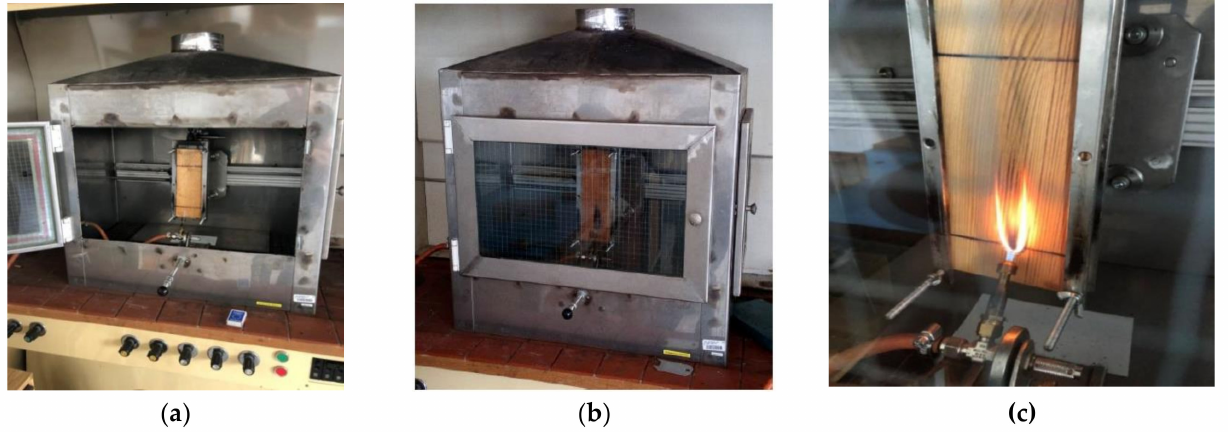
Figure 3. ( a ) Prepared experiment; ( b ) experiment at 10 s; ( c ) close-up of flame–sample contact at 20